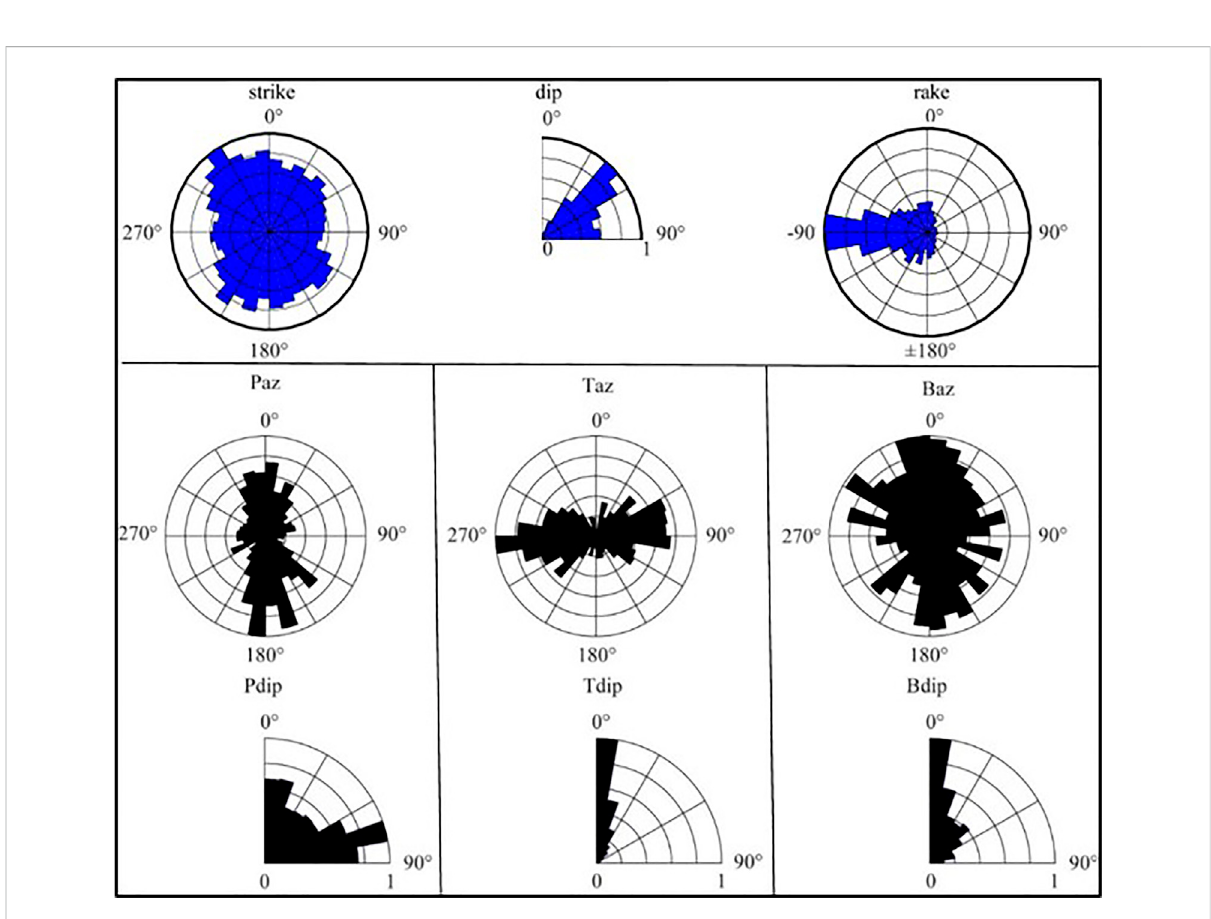
FIGURE 3 Windrosemapshowingnodalplanesandthreefocalmechanismaxes.Thetoplineshowsstrikes,dipanglesandrakesofthefocalmechanisms, and three columns below show azimuths and dip angles for three axes including P, T and